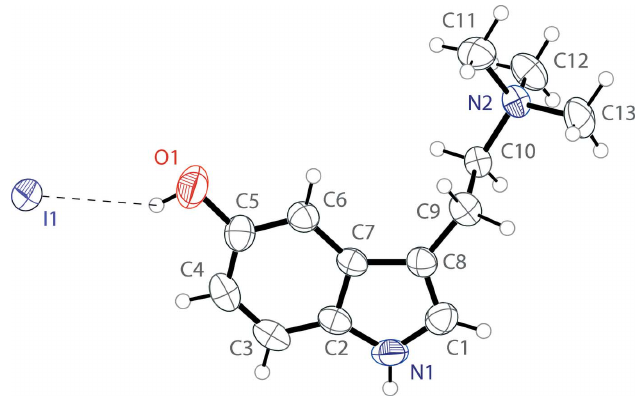
Figure 1 The molecular structure of 5-hydroxy- N , N , N -trimethyltryptammonium (5-HTQ) iodide, showing the atom labeling. Displacement ellipsoids are drawn at the 50% probability level. A hydrogen bond is shown as a dashed